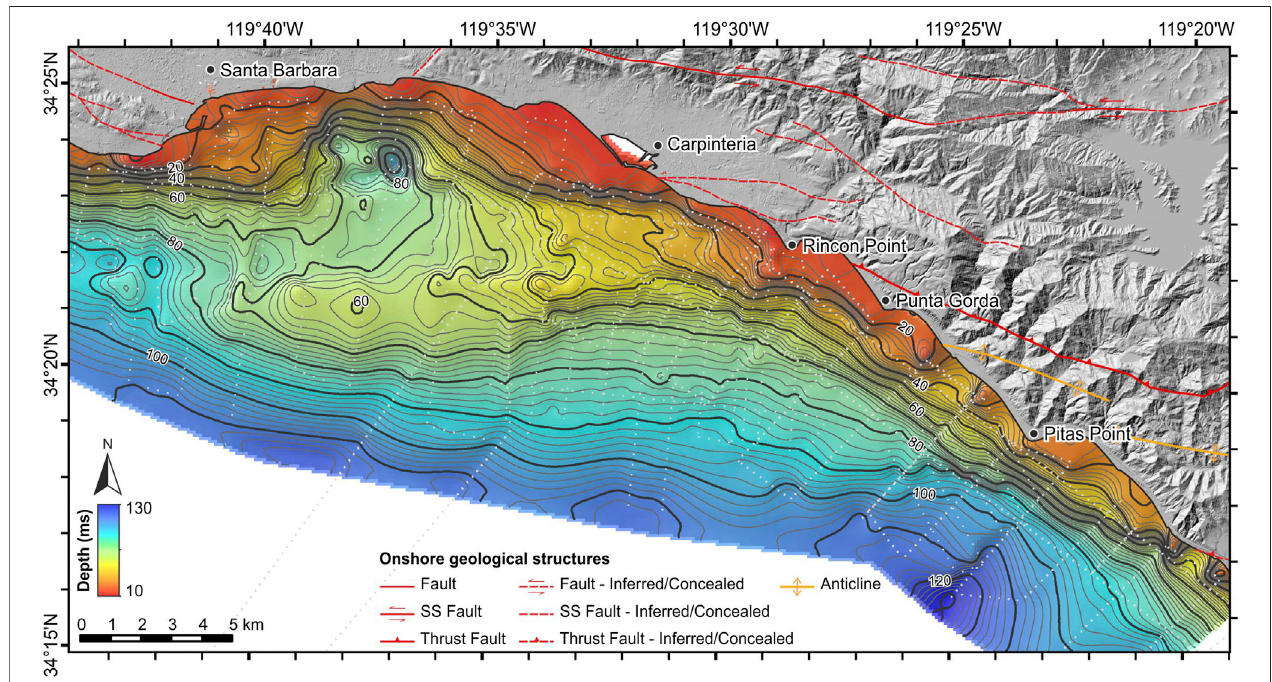
FIGURE8| StructuralcontourmapoftheLastGlacialtransgressivesurface(LGTS)inmillisecondstwo-way traveltime(TWTT)fortheoffshoreregion.Controllines areshownbywhitedottedlines.Note theENE-WSWelongatedhighstartingatRinconPointandthedepressionbetweenitand thecoastline,whichcorresponds tothe Inner Santa Barbara Basin. Within this elongate depression, there is an abrupt short wavelength deepening (80 ms) of the LGTS. Main contour lines (black) are every 10 ms and secondary contour lines (gray) every 2 ms. For the interpolation, we used the Flex Gridding algorithm in IHS Kingdom software. Onshore shaded relief map shows the location of the main active faults (Jennings and Bryant, 2010). The location of this fi gure is shown in Figure 1 .